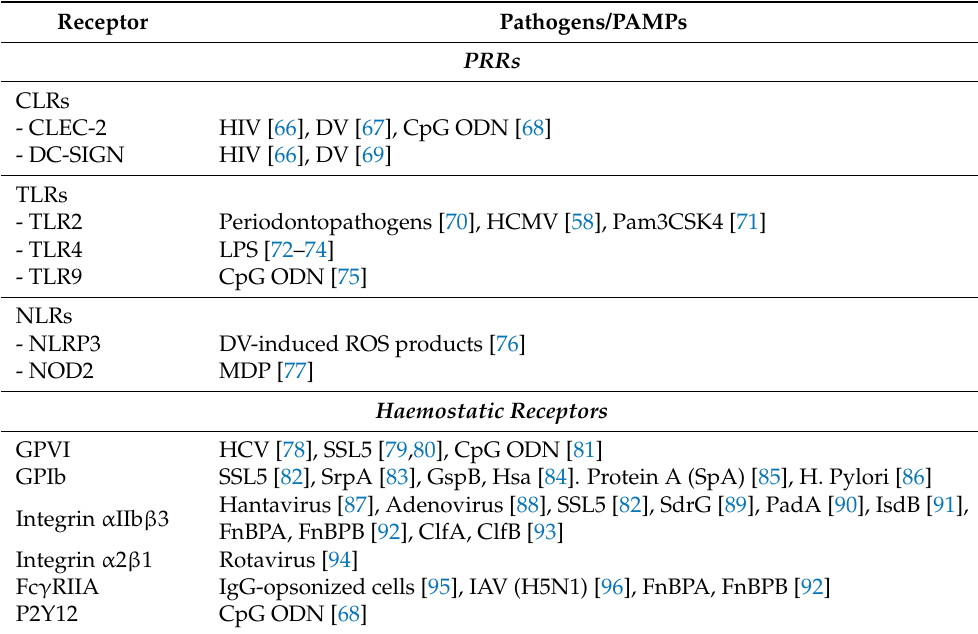
Table 3. Platelet receptors involved in pathogen